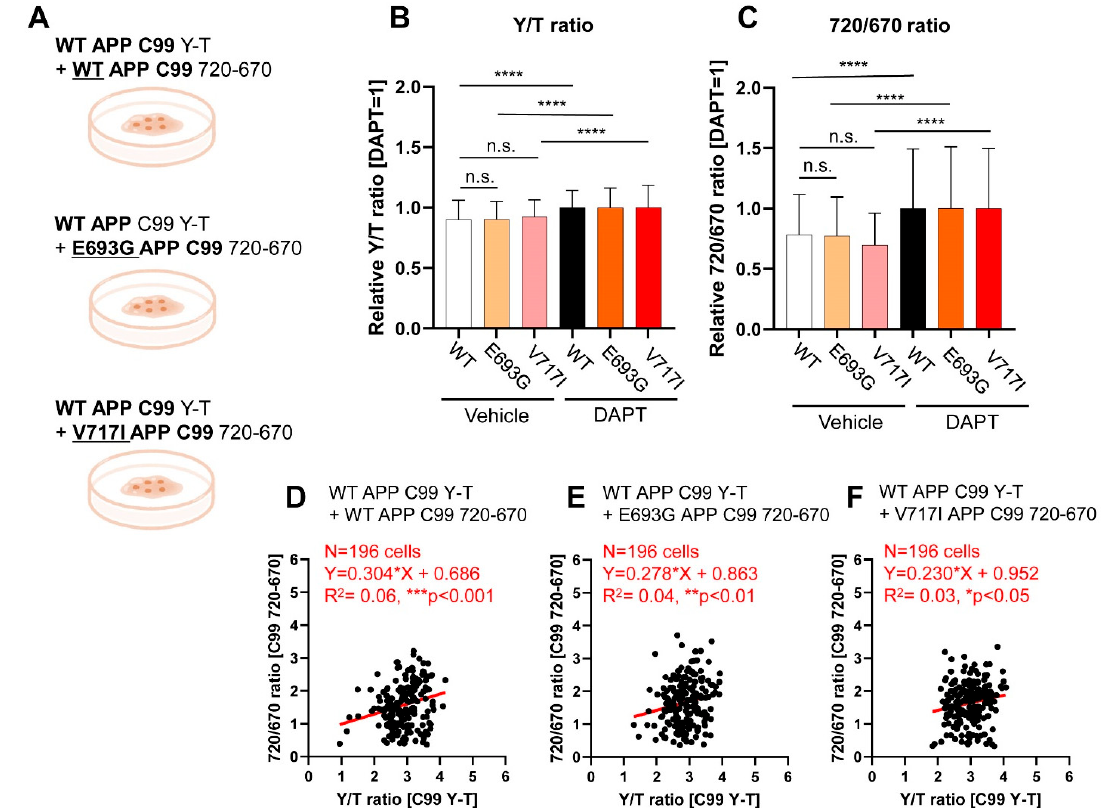
Figure 2. Simultaneous monitoring of WT and FAD-linked mutants APP C99 processing by PS/ γ -secretase: ( A ) Schematic representation of the experimental groups: the WT APP C99 Y-T biosensor was co-transfected into CHO cells in combination with the WT or FAD mutant C99 720-670 biosensors; ( B ) The relative Y/T ratio was comparable among three groups, suggesting that the C99 Y-T biosensor was equally processed in the presence of WT or FAD mutants C99 720-670 biosensors. n = 196, one-way ANOVA, n.s. not significant, **** p < 0.0001; ( C ) Similarly, relative 720/670 ratio was not different between WT versus mutants C99 720-670 biosensors expressing cells. n = 196, one-way ANOVA, n.s. not significant, **** p < 0.0001. Scatterplots of 720/670 and Y/T ratios in the cells expressing the C99 Y-T biosensor together with the WT C99 720-670 ( n = 196, Y = 0.304X + 0.686, R 2 = 0.06, *** p < 0.001) ( D ); the E693G C99 720-670 ( n = 196, Y = 0.278X + 0.863, R 2 = 0.04, ** p < 0.01) ( E ); or the V717I C99 720-670 biosensor ( n = 196, Y = 0.230X + 0.952, R 2 = 0.03, * p < 0.05) ( F ). Pearson correlation coefficient squared demonstrates a positive correlation between the Y/T ratio (representing the C99 Y-T processing) and 720/670 ratio (cleavage of the wild-type or FAD mutants C99 720-670).